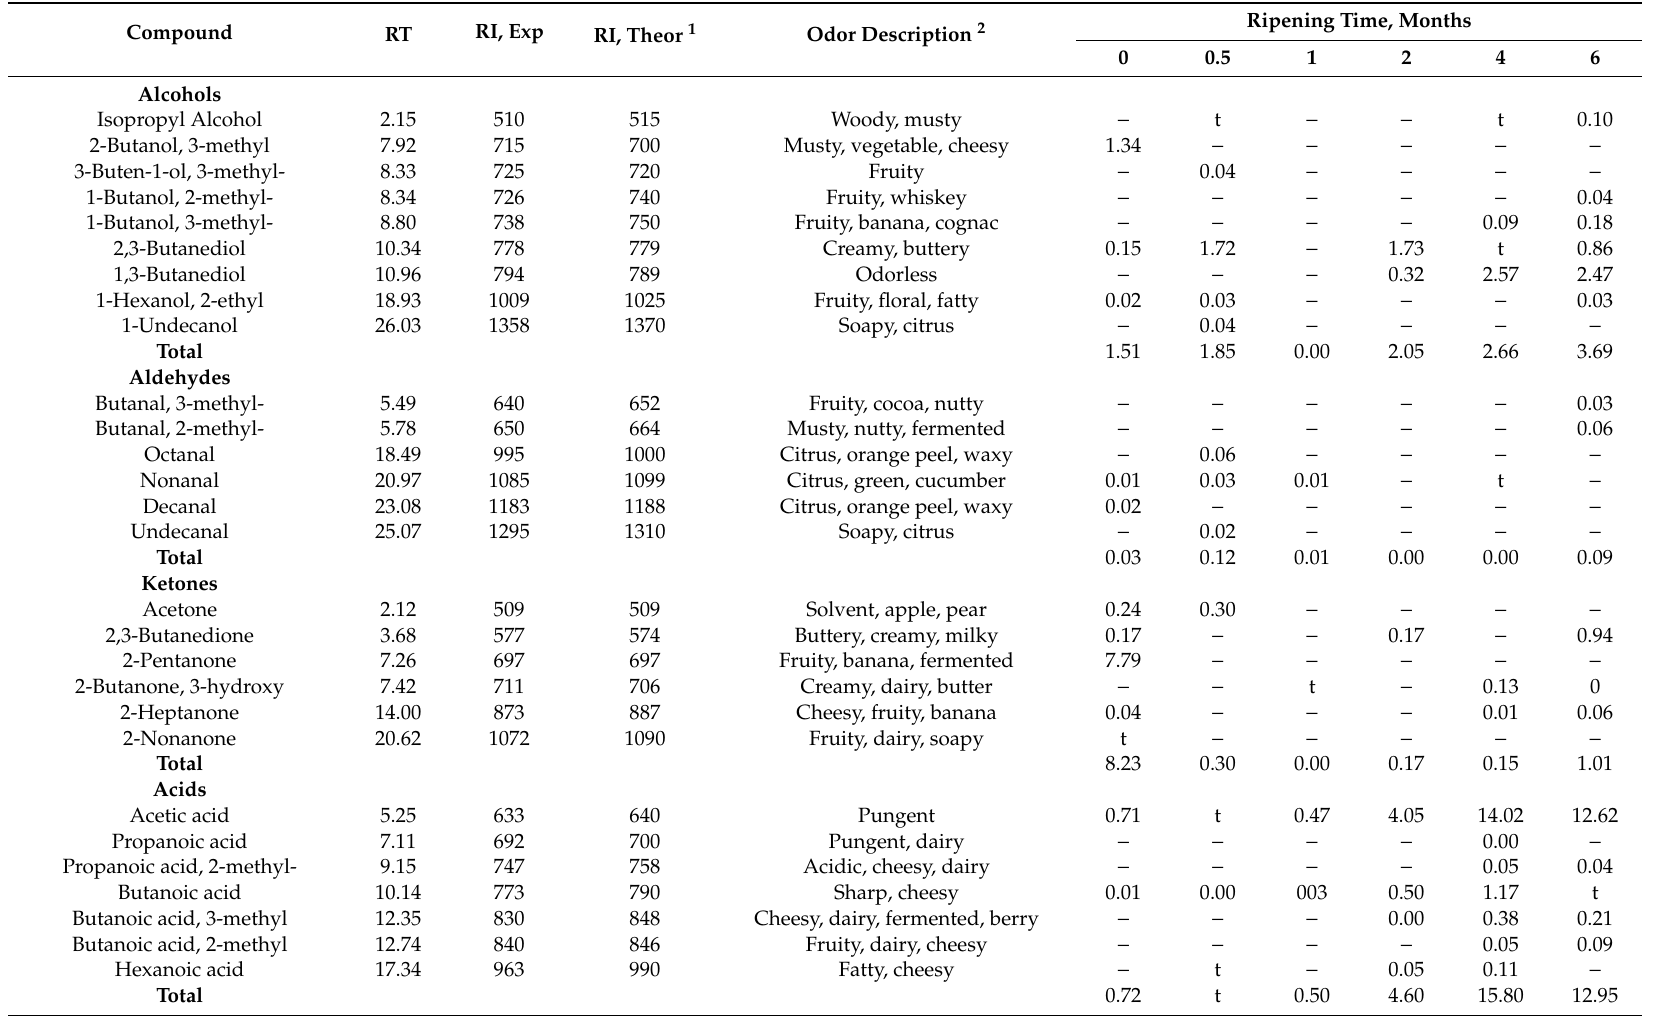
Table 2. Volatile compounds identified in RO-cheese during ripening (AU × 10 4 ). Results are the means of three GC-MS measurements. AU, arbitrary units (peak area).